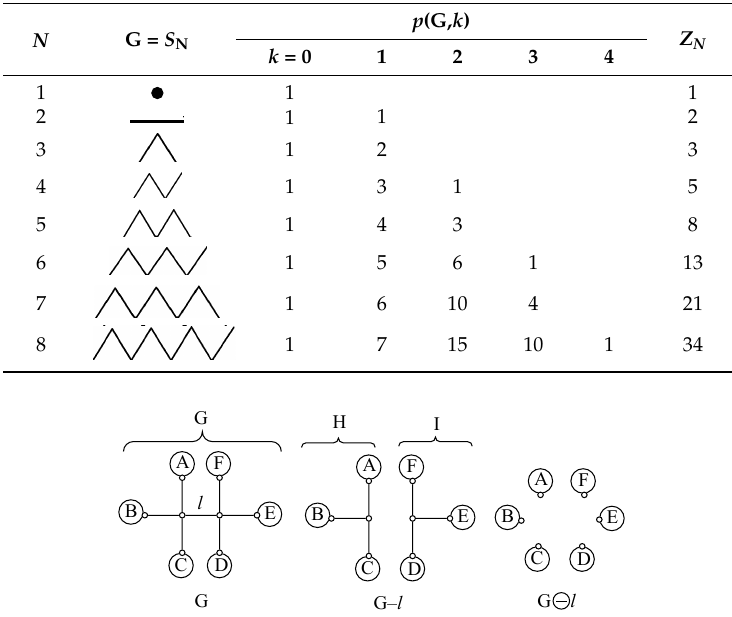
Table A1. p (G, k ) and Z -index of path graph S N .